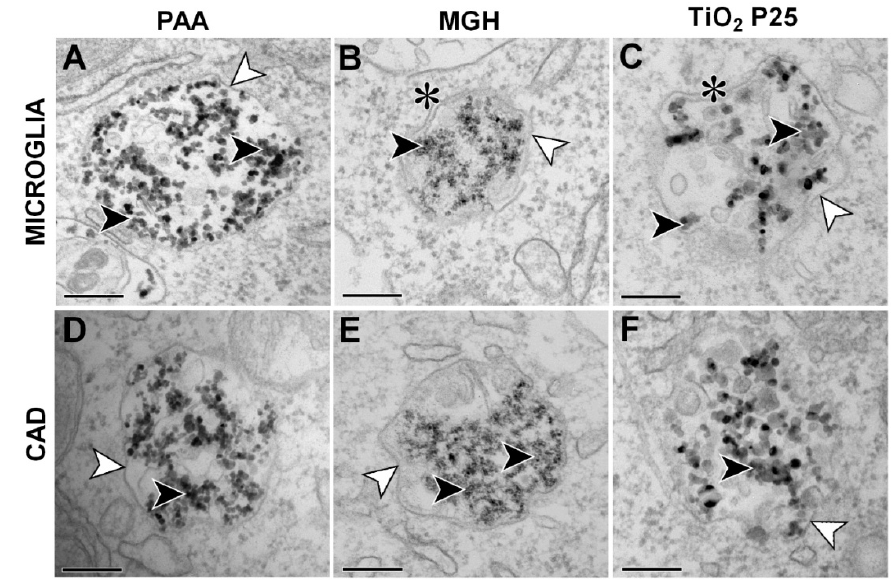
Figure 2. Confirmation of internalization of ( A , D ) biomedical polyacrylic acid (PAA) coated cobalt ferrite NPs, ( B , E ) uncoated maghemite (MGH) NPs and ( C , F ) industrial TiO 2 P25 NPs in mouse microglial cells ( A – C ) following 24 h incubation and differentiated CAD cells ( D – F ) following 48 h incubation with 25 µg/mL of NPs. NPs are denoted by full arrowheads and vesicular membranes by empty arrowheads. Double membranes, typical of amphisomes or autophagosomes, are denoted by asterisks. Scale bars correspond to 200